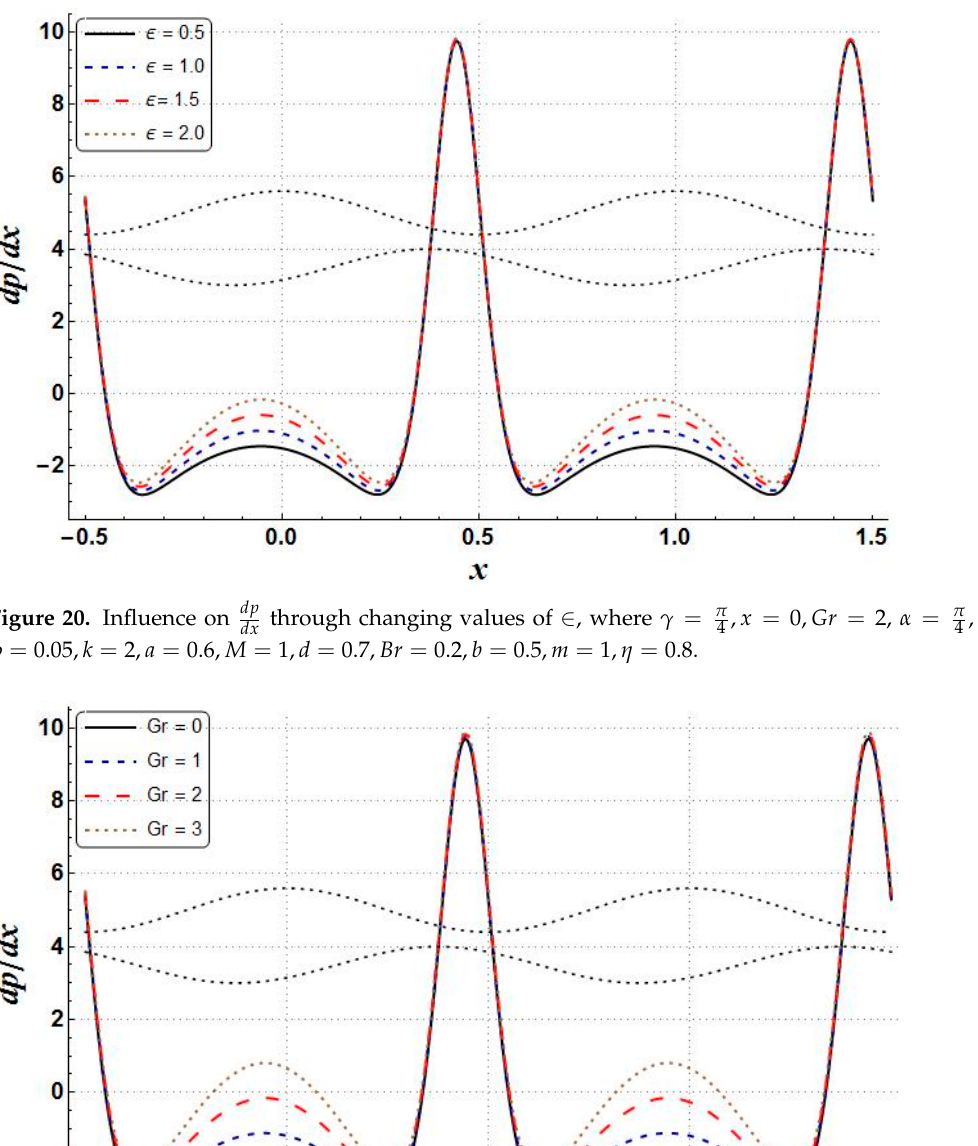
Figure 21. Influence on dp through changing values of Gr , where γ = π dx α = π , φ = 0.05, k = 2, a = 0.6, M = 1, d = 0.7, m = 1, b = 0.5, ∈ = 2, η = 4